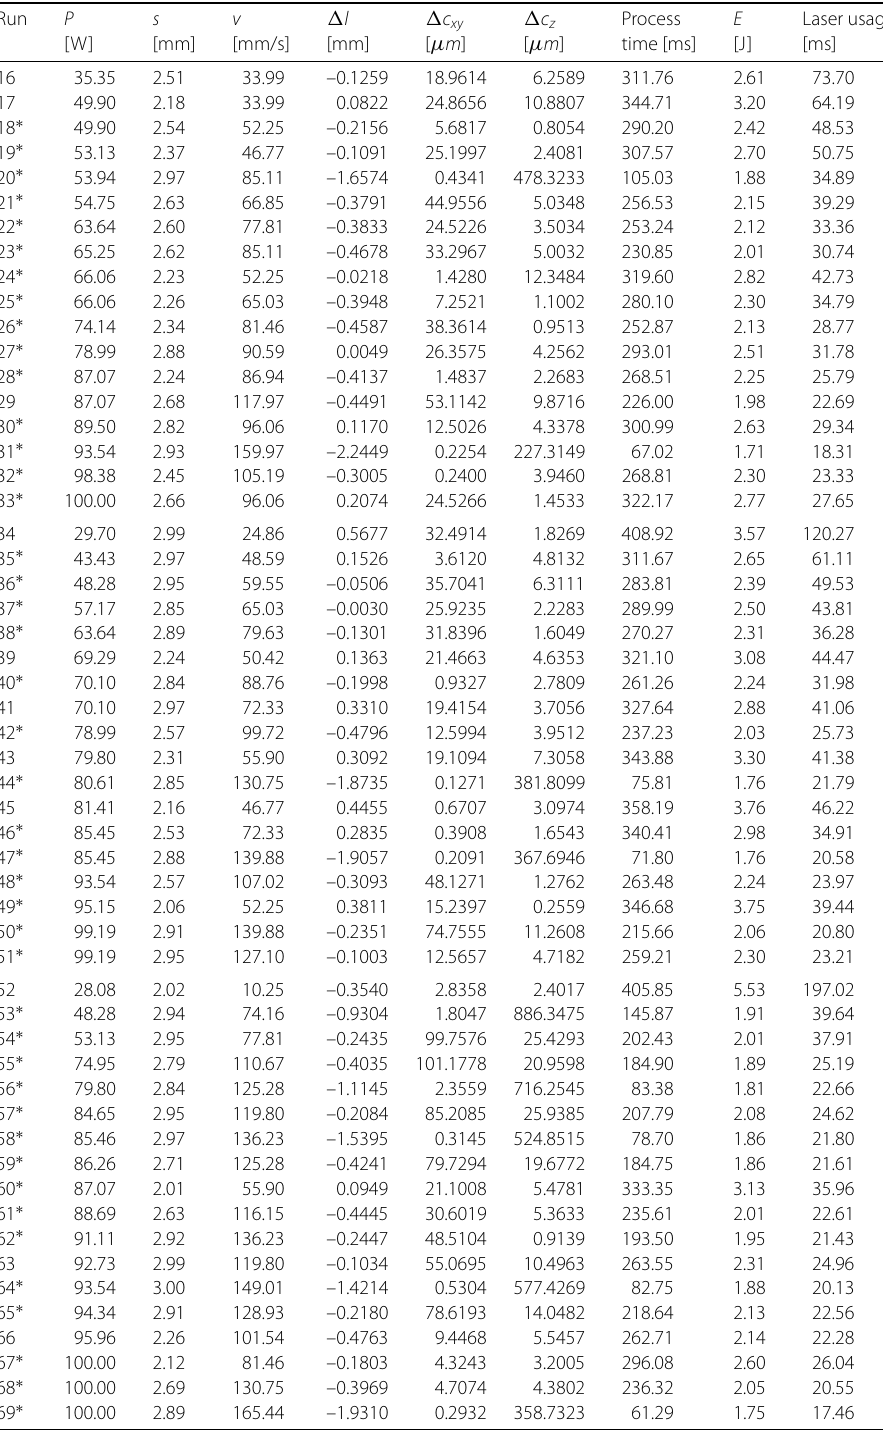
Table 5 Case Study 2: Evaluation of selected predicted Pareto solutions. Iterations are divided by horizontal lines. Iteration 1: solutions 16 to 33, Iteration 2: 33 to 51, Iteration 3: 52 to